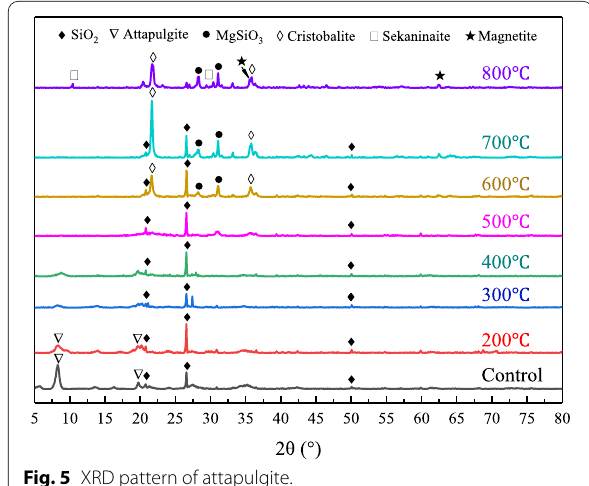
Fig. 5 XRD pattern of